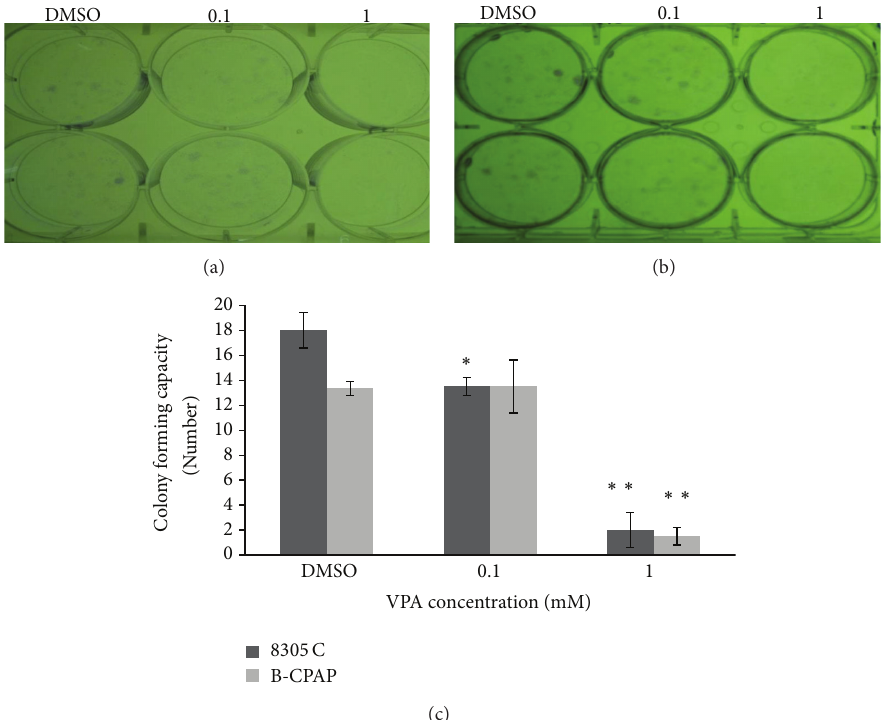
Figure 3: Colony forming capacity of the cells after VPA treatment. Papillary (a) and anaplastic (b) cells were seeded in 6-well plate, and after attachment for 3h, cells were treated with 0.1 and 1mmol/L of VPA for 2 weeks. After 2 weeks colonies were fixed with glutaraldehyde (6.0%, v/v), stained with crystal violet (0.5% w/v) and the number of colonies with at least 50 cells was counted. (c) Each data is expressed as mean of colony forming cells ± SD. Statistically different values of ∗ 𝑃 < 0.05 , ∗∗ 𝑃 < 0.01 , and ∗∗∗ 𝑃 < 0.001 were determined significantly compared with the corresponding control.